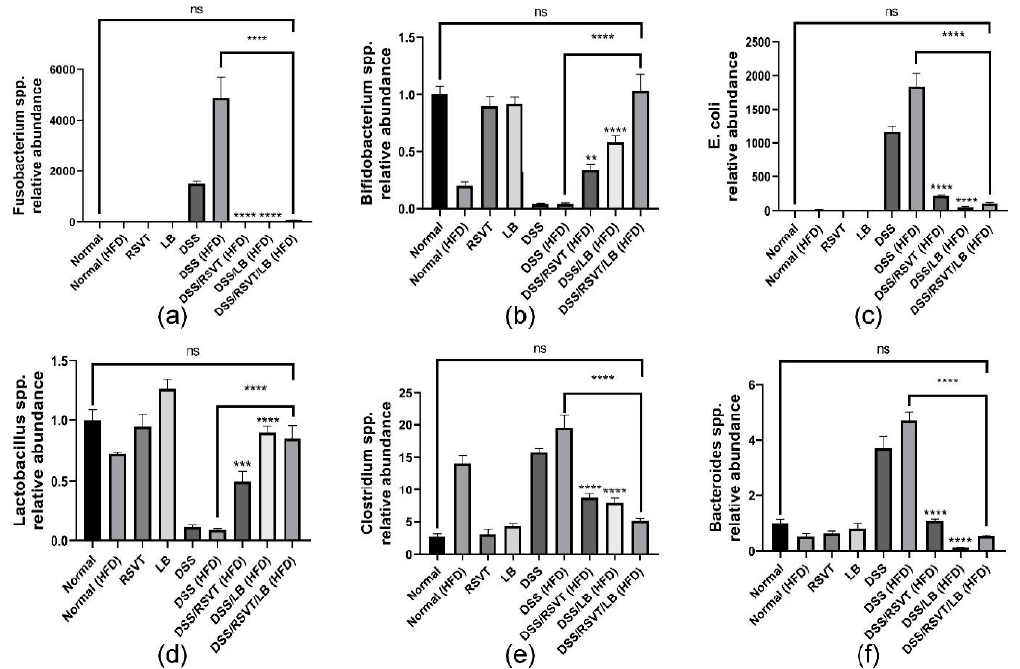
treated with RSVT, LB, or their combination, whereas Bifidobacterium spp. and Lactobacillus spp. were markedly abundant in the control samples and treated rat groups.